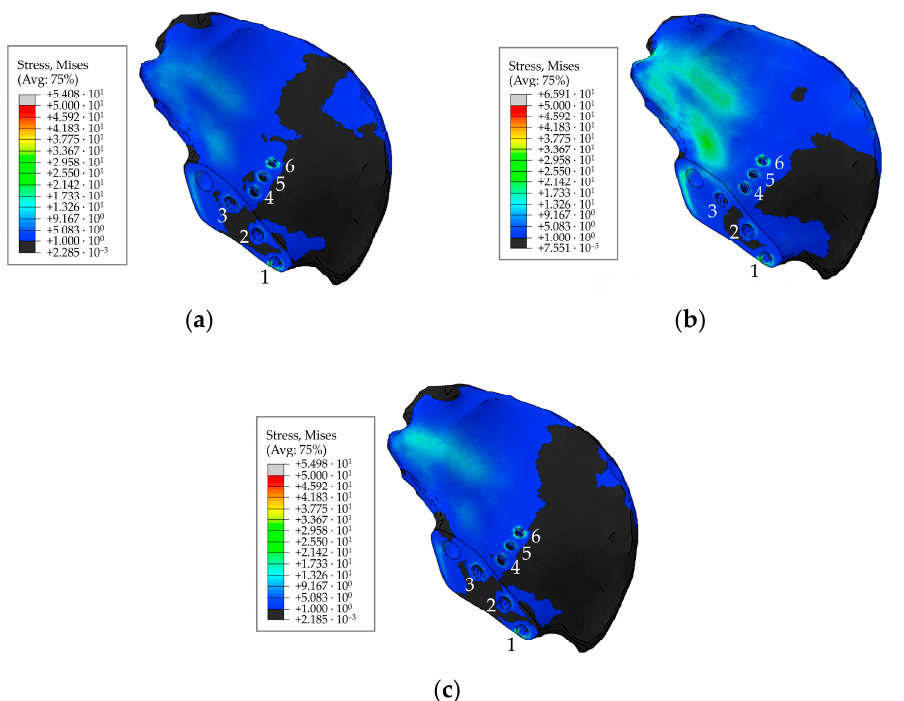
Figure 22. Stress distribution for a pretension force of 500 N and the hole numbering convention in the right pelvic bone: ( a ) in 63% phase; ( b ) for ascending stairs; ( c ) for descending stairs, MPa.